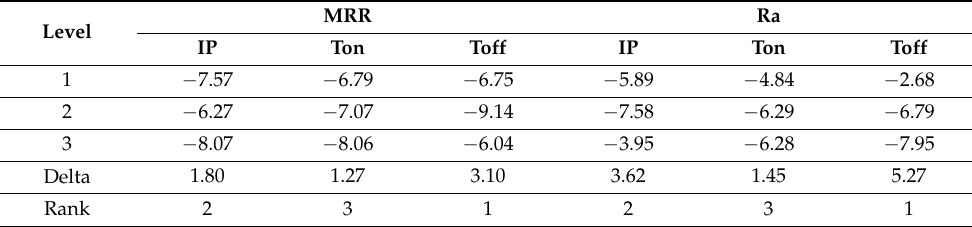
Table 3. S/N ratio response for the untreated electrode.